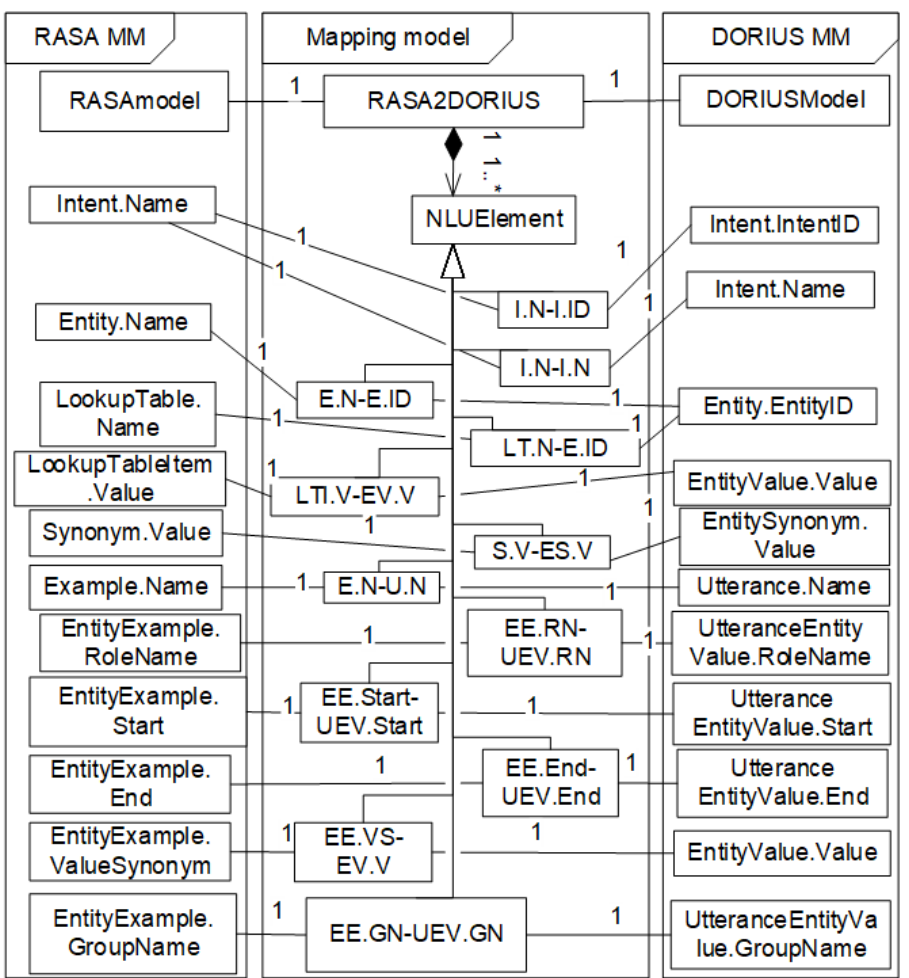
Figure 7. RASA—DORIUS Mapping